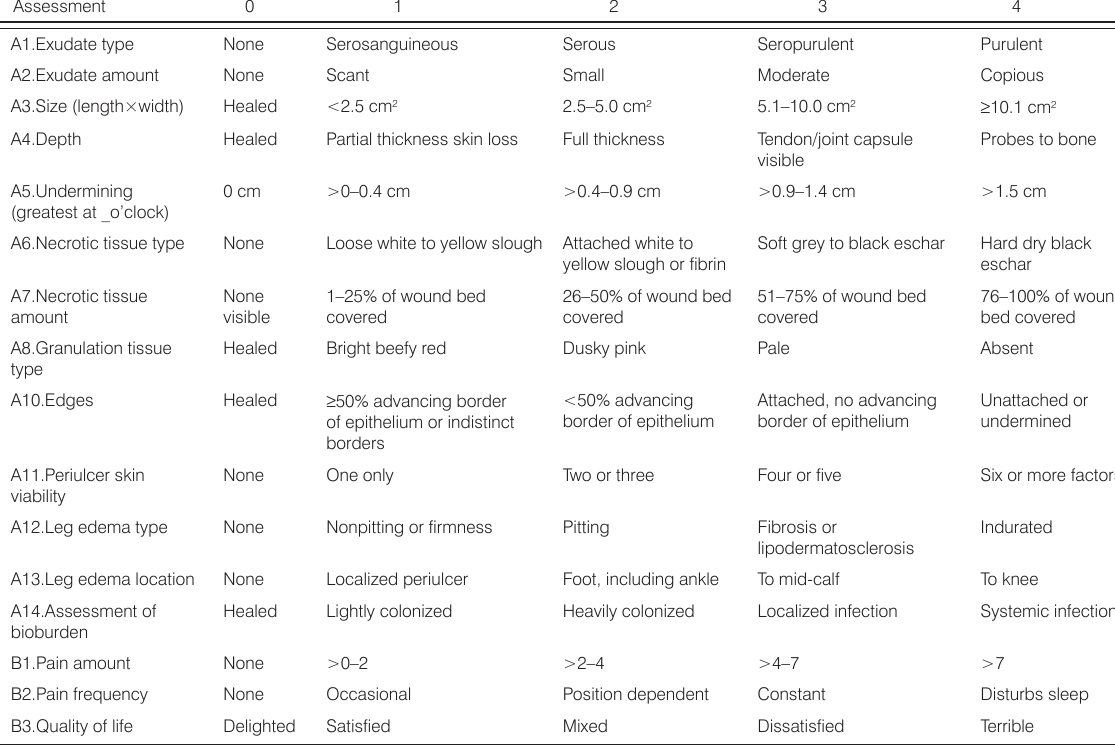
Table 1. Leg ulcer measurement